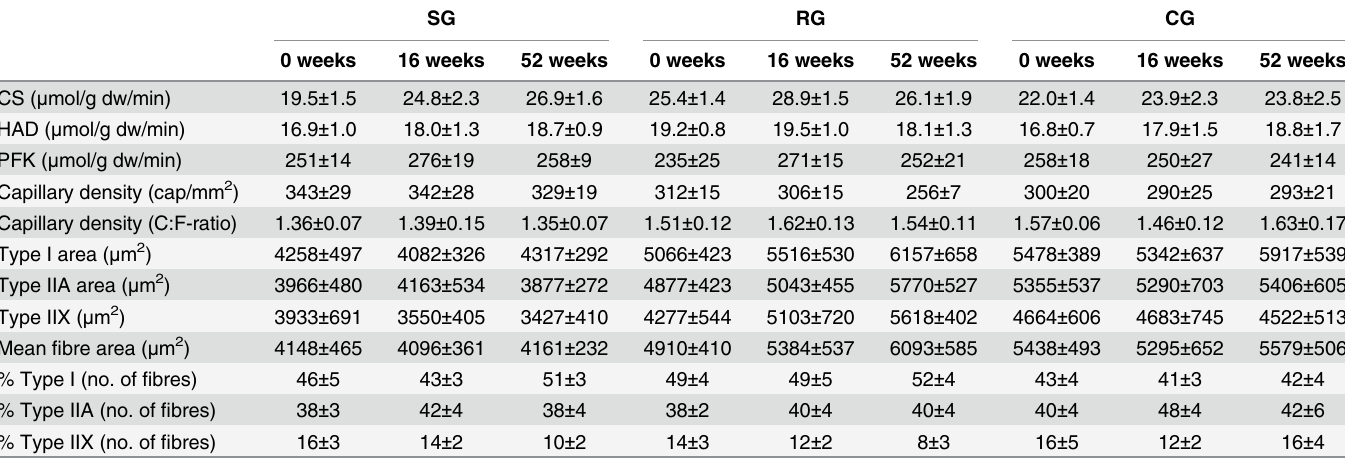
Table 3. Muscle variables during 52 wks of soccer or resistance training in elderly men.